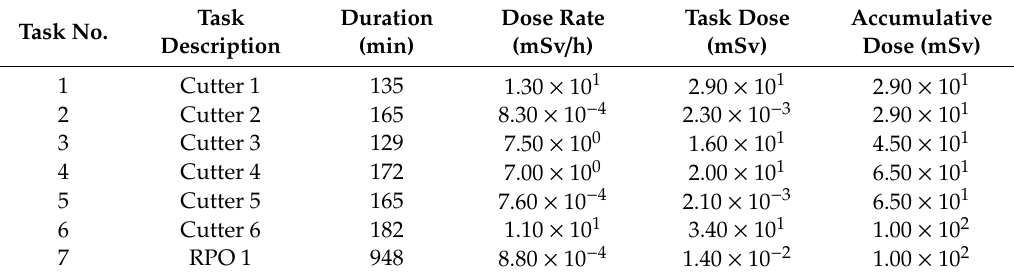
Table 4. Task information for the fragmentation of the upper part.